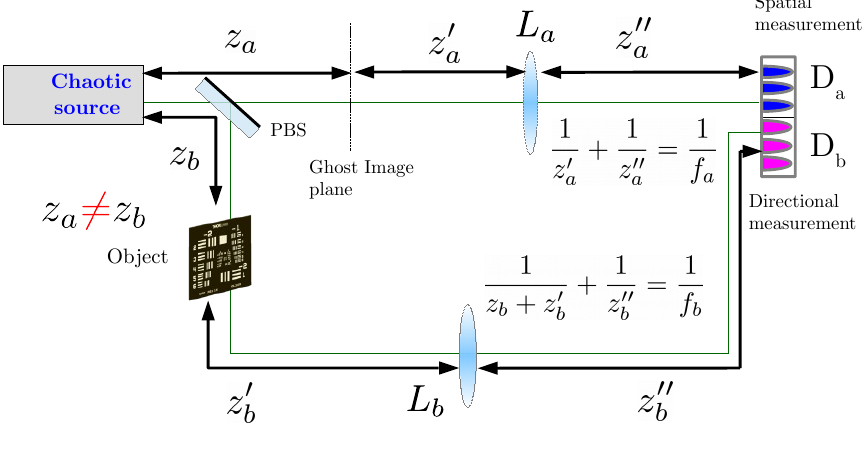
Figure 10. Experimental setup for the proof-of-principle demonstration of correlation plenoptic imaging with chaotic light. Adapted with the permission from [42], copyright American Physical Society,